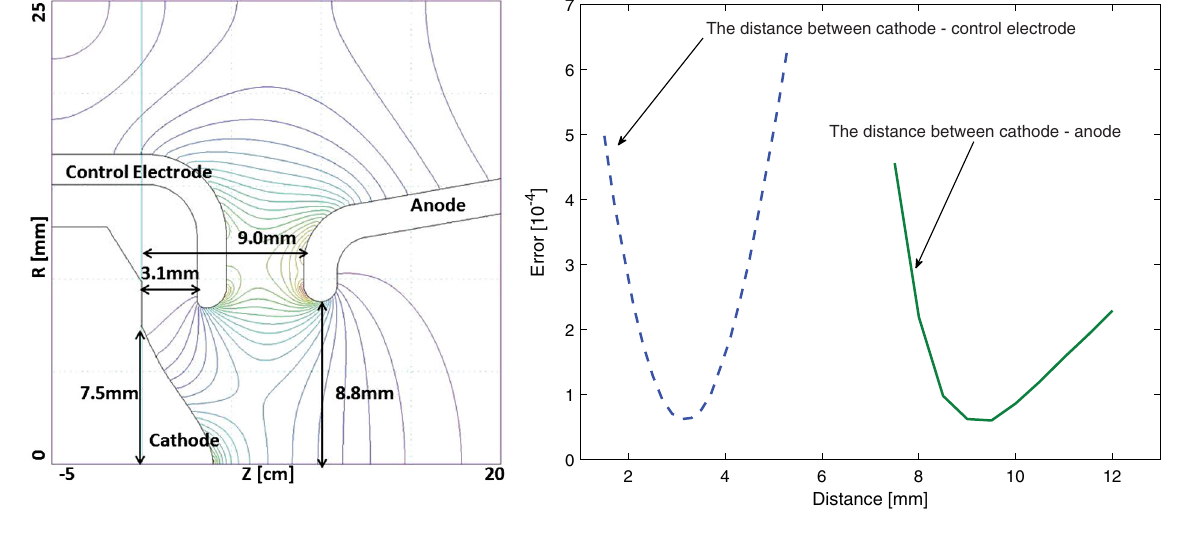
FIG. 4. Electron gun design and optimization.